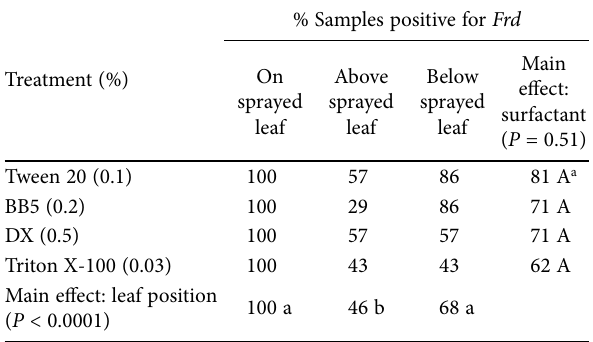
Table 1. Mean proportions of grapevine tissue samples containing Frateuria defendens ( Frd ; determined by PCR) after spray applica- tion of bacterial suspensions on different leaf positions on potted grapevine plants 7 dpi (N = 7 per treatment). Main effects: sur- factant type, and leaf position relative to sprayed site. Statistical sig- nificance was calculated separately for each main effect.